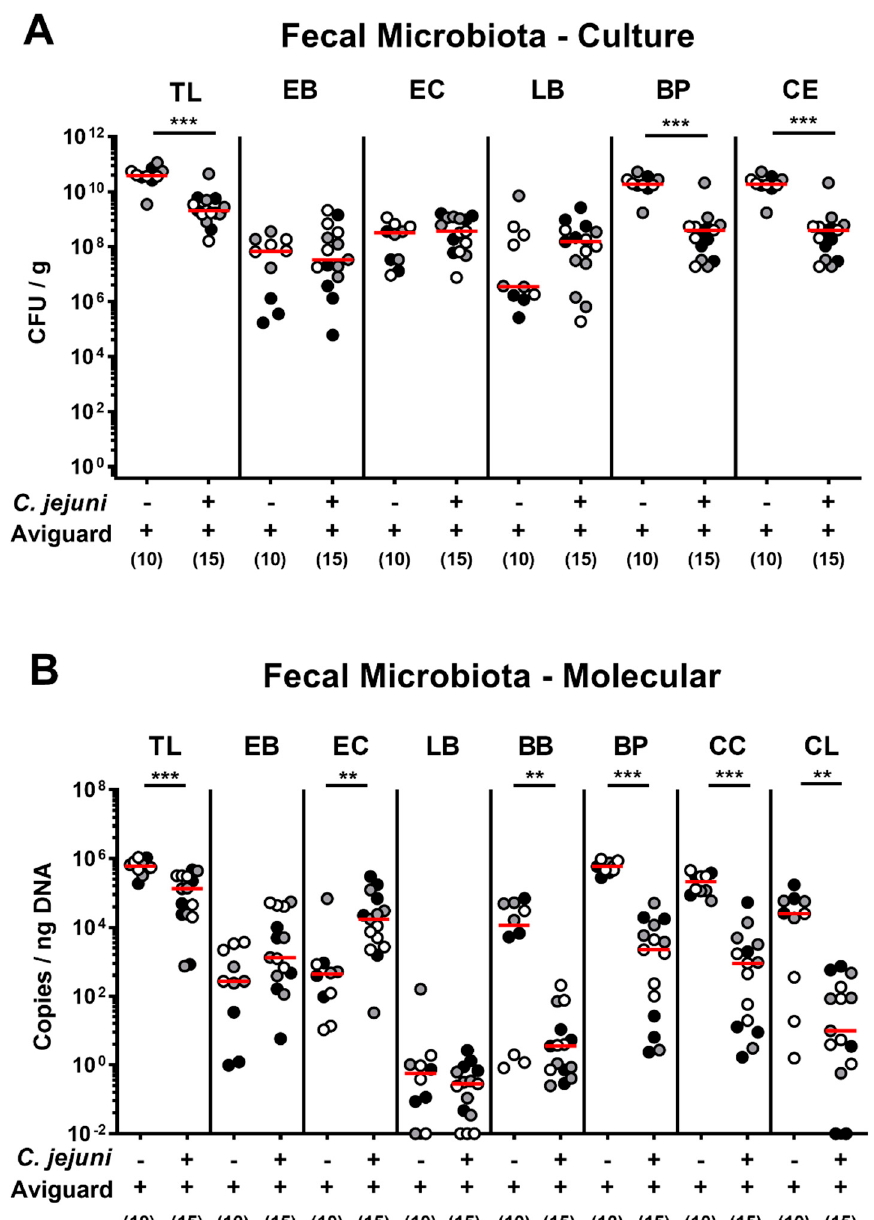
Figure 2. Aviguard ® treatment and intestinal microbiota composition of C. jejuni -infected microbiota-depleted IL-10 − / − mice. Following C. jejuni strain 81-176 infection on days 0 and 1, microbiota-depleted IL-10 − / − mice were perorally treated with Aviguard ® on days 2, 3, and 4 ( n = 15). The fecal microbiota composition was surveyed on day 6 post-infection applying ( A ) culture (in colony forming units per g, CFU/g) and ( B ) culture-independent (molecular) methods (in copies/ng DNA). Aviguard ® -treated uninfected animals were included as controls ( n = 10). Medians (red bars) and significance levels ( p values) determined by the Mann Whitney U -test are shown. Data were pooled from three independent experiments (as indicated by black, white, and gray circles). TL, total bacterial load; EB, enterobacteria; EC, enterococci; LB, lactobacilli; BP, Bacteroides/Prevotella species; CE, Clostridium/Eubacterium species; BB, bifidobacteria; CC, Clostridium coccoides group; CL, Clostridium leptum group. ** p < 0.01; *** p < 0.001.